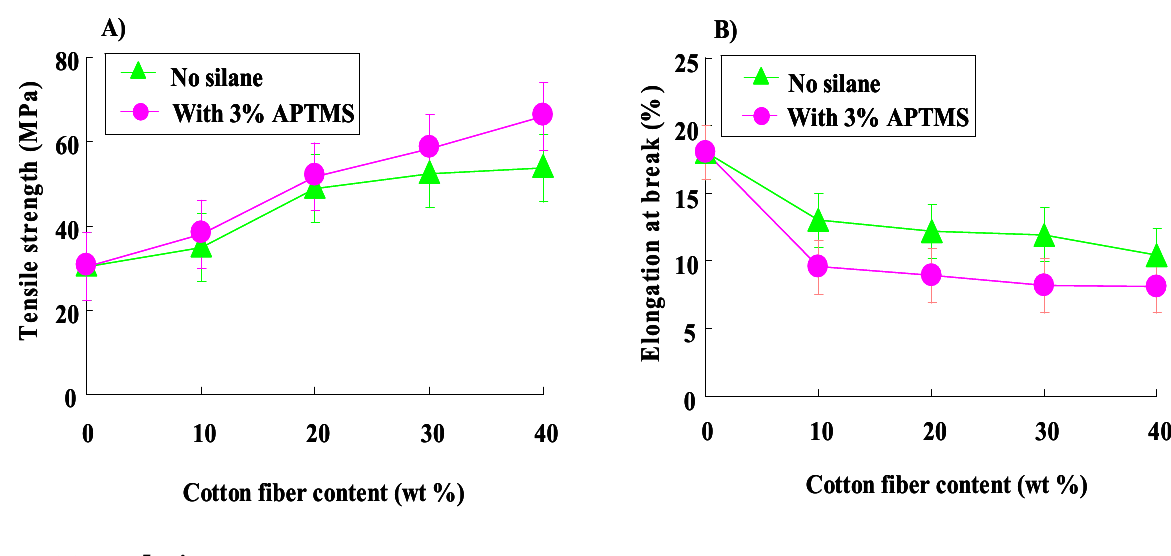
Figure 3. Effect of silane treatment (with 3% APTMS) on the ( A ) tensile strength and ( B ) elongation at break of PBS/CF